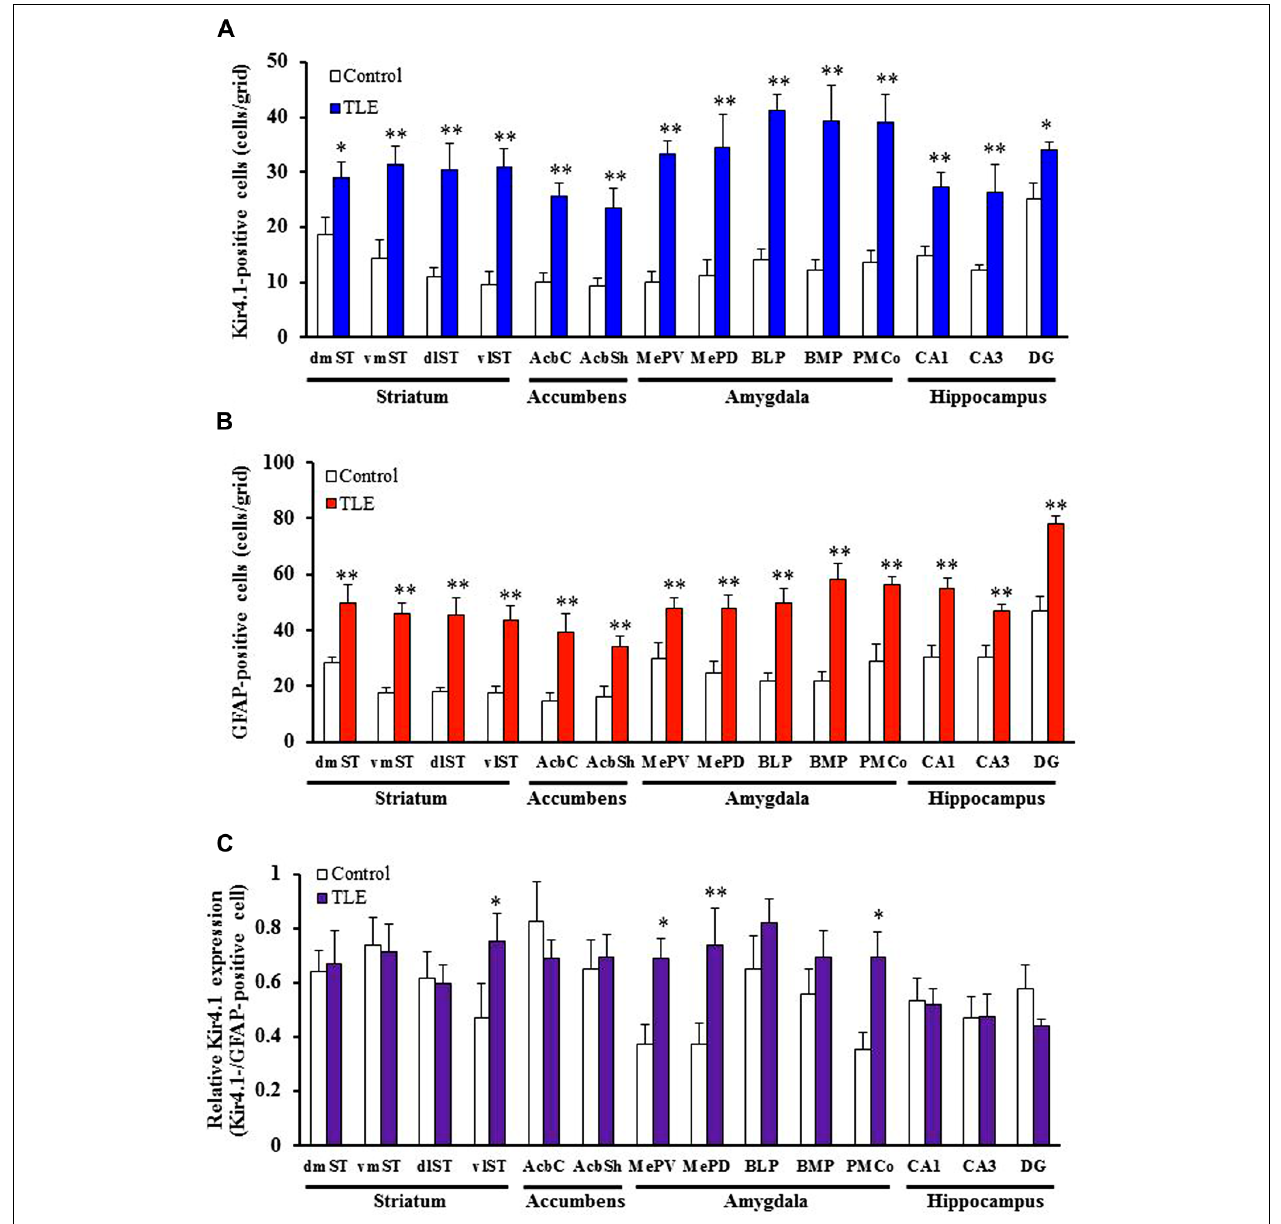
dlST, and vlST, dorsomedial, ventromedial, dorsolateral, and ventrolateral striatum, respectively; AcbC and AcbSh, core and shell regions of the nucleus accumbens, respectively; MePV and MePD, medial amygdaloid nucleus, posteroventral and posterodorsal part; BLP, basolateral amygdaloid nucleus, posterior part; BMP, basomedial amygdaloid nucleus, posterior part; PMCo, posteromedial cortical amygdaloid nucleus; CA1, CA3, and DG, CA1, CA3, and dentate gyrus of the hippocampus. Each column represents the mean ± SEM of seven animals. * P < 0.05, ** P 0.01, significantly different from control rats.